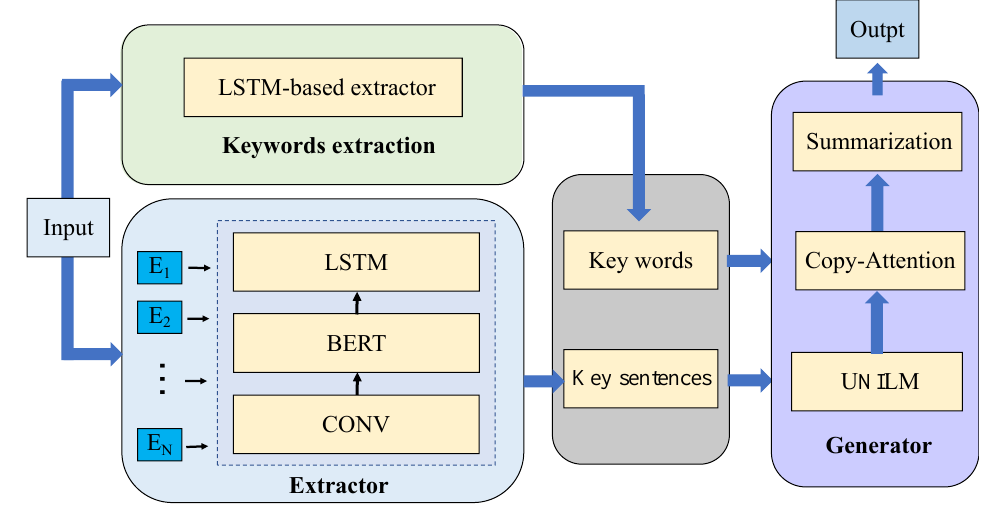
Figure 2. Overall framework of our proposed two-stage model. In stage one, we utilized the CONV + BERT + LSTM model to realize the extraction of key sentences and adopted an extractive method based on BiLSTM to extract keywords. In stage two, we sent this information to the abstractive model, which consisted of a UNILM model and an attention mechanism, which then could generate a